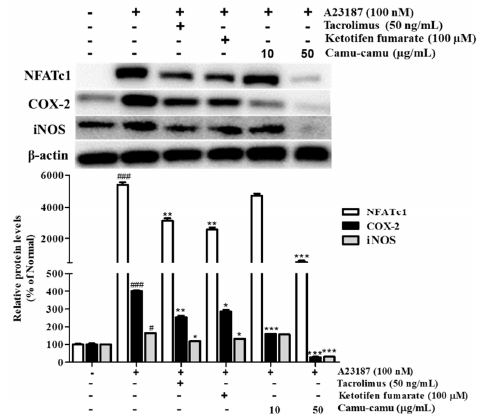
Figure 10. Effect of camu-camu fruit extract on NFAT activation in A23187-induced RBL-2H3 cells. Band intensities were quantified by densitometry, normalized to the level of β -actin. Then, it was calculated as a percentage of non-treated cells and displayed as mean ± SD of three independent experiments ( # p < 0.05 and ### p < 0.001 vs. the control group, * p < 0.05, ** p < 0.001 and *** p < 0.001 vs. the A23187-treated group).